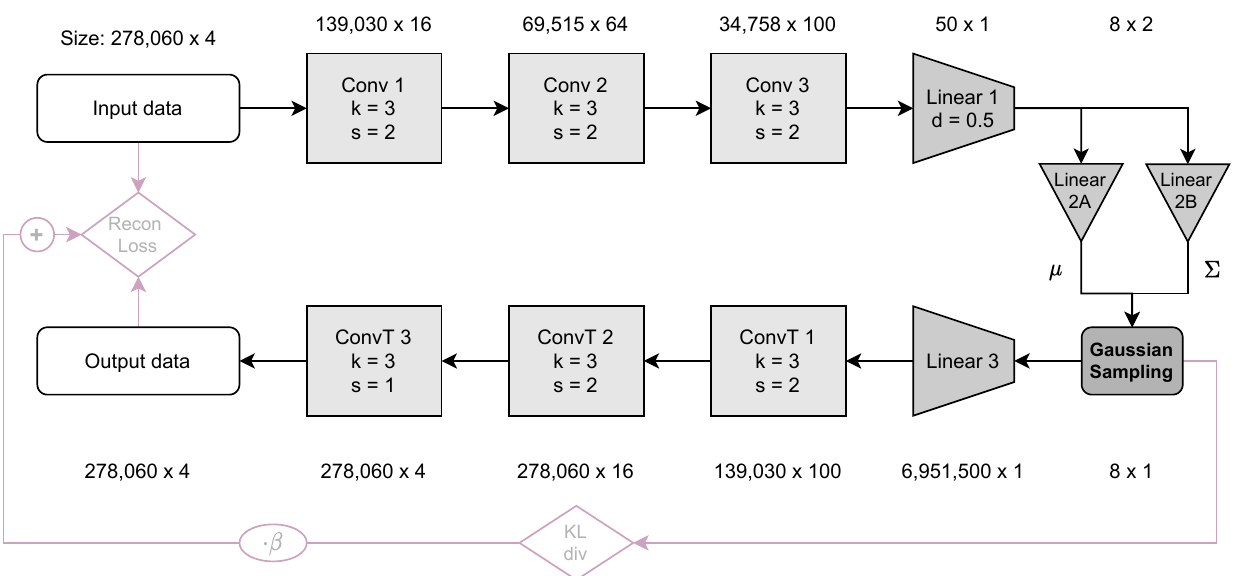
Figure 2. VAE architecture. The format given for the data dimensions is N × C with N representing the number of variables and C representing the number of channels. k is the kernel size of the filters in the corresponding layer and s is the stride parameter, which defines the step size of the convolution operations within the respective